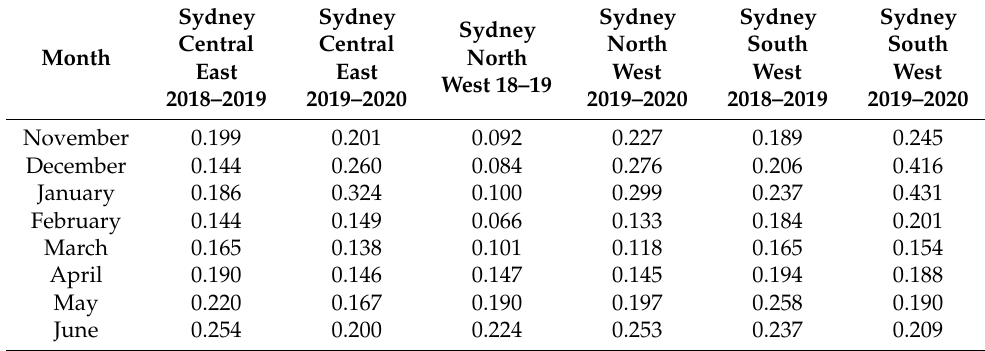
Table 2. Maximum CO [ppm] emission for a wide range of periods in different areas of Sydney.